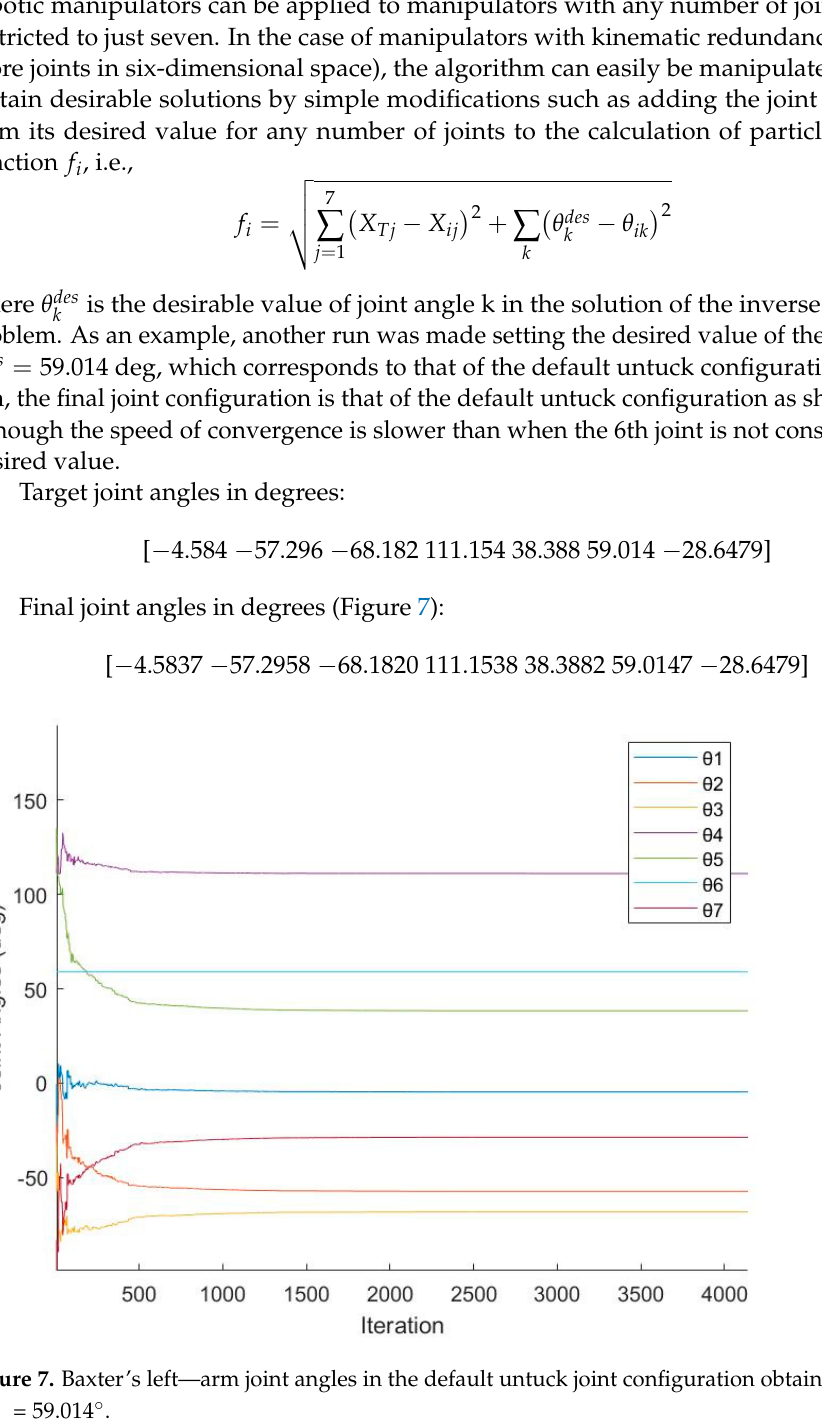
Figure 7. Baxter’s left—arm joint angles in the default untuck joint configuration obtained by setting θ des = 59.014°.